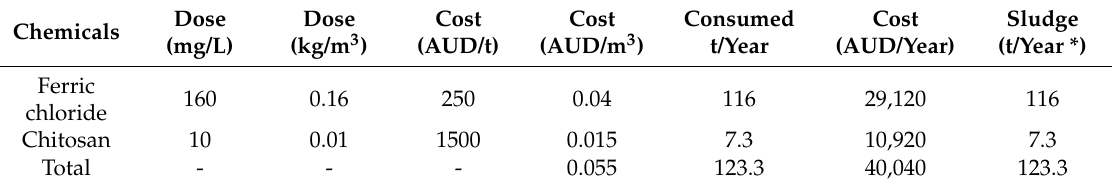
Table 17. Amount of ferric chloride and chitosan required and their costs.